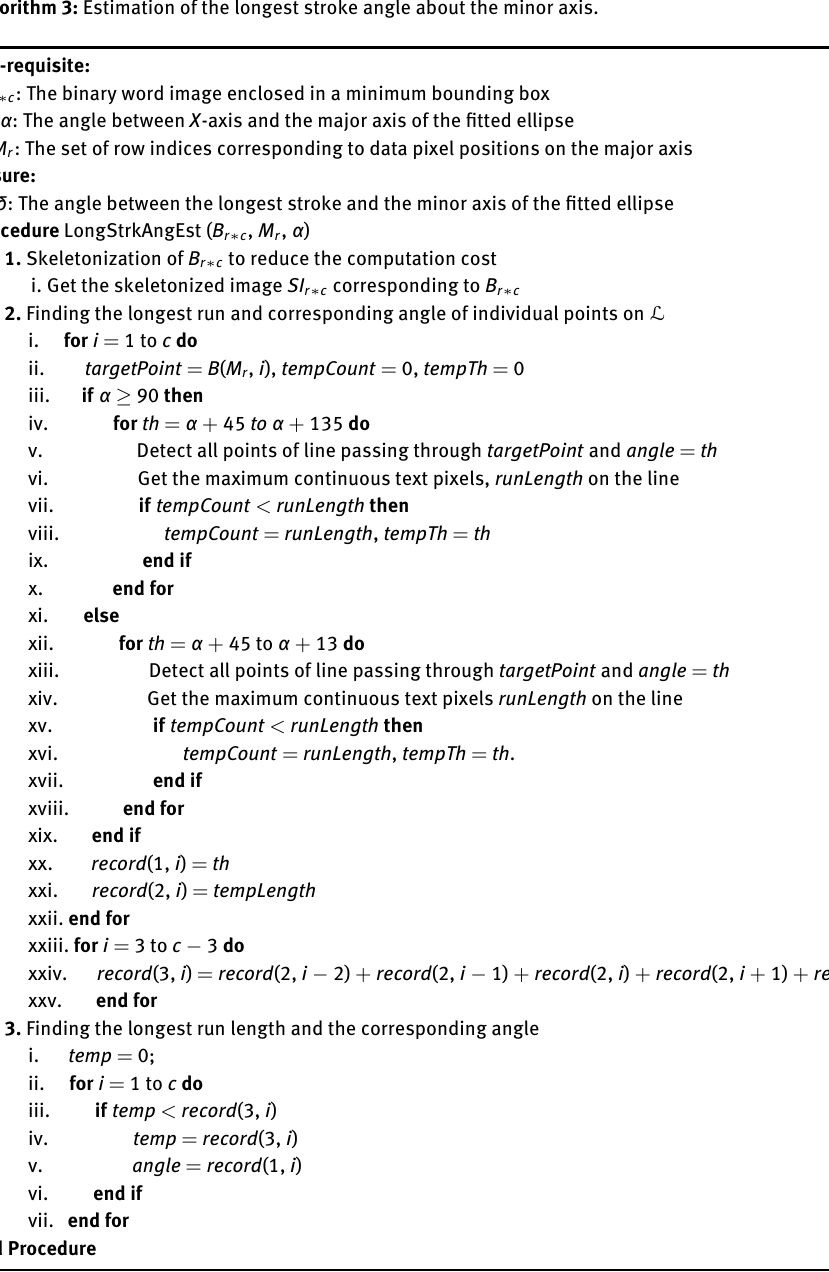
Algorithm 3: Estimation of the longest stroke angle about the minor